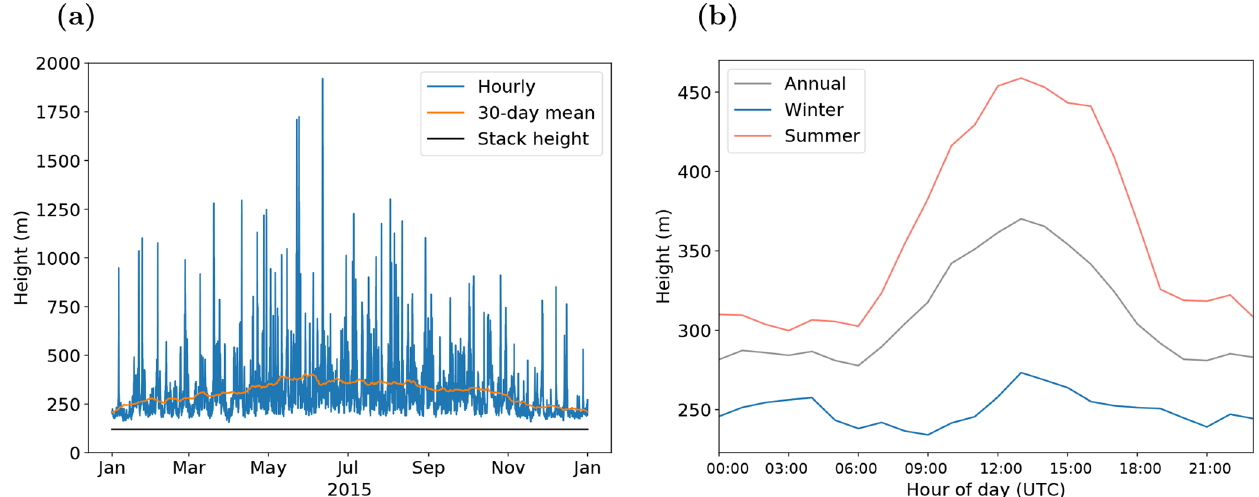
Figure 3. Effective CO 2 emission heights at the power plant in Jänschwalde, Germany, based on plume rise calculations. (a) Hourly plume rise in 2015. The orange line is a 30-day moving average. The black solid line denotes the height of the cooling tower (120m). (b) Mean annual, winter (DJF) and summer (JJA) diurnal cycles.